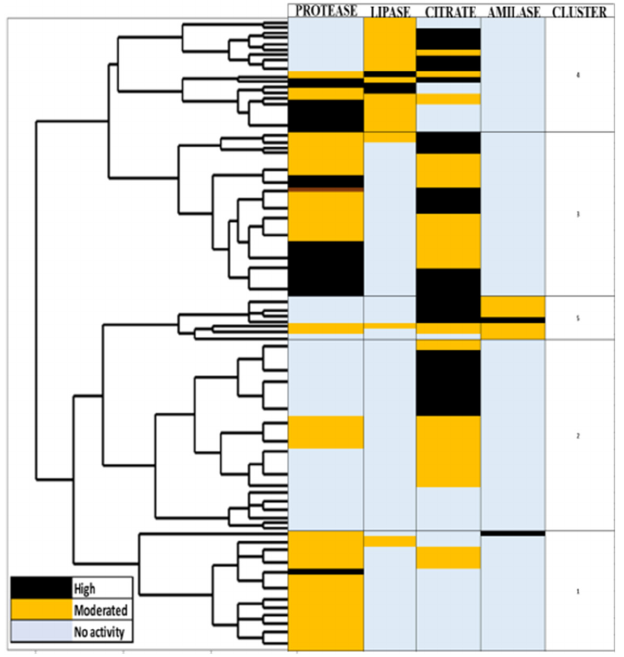
Figure 2. Dendogram of the behavior of LAB enzymatic activity (protease, lipase, amylase, citrate metabolism) grouped in clusters with a similarity of